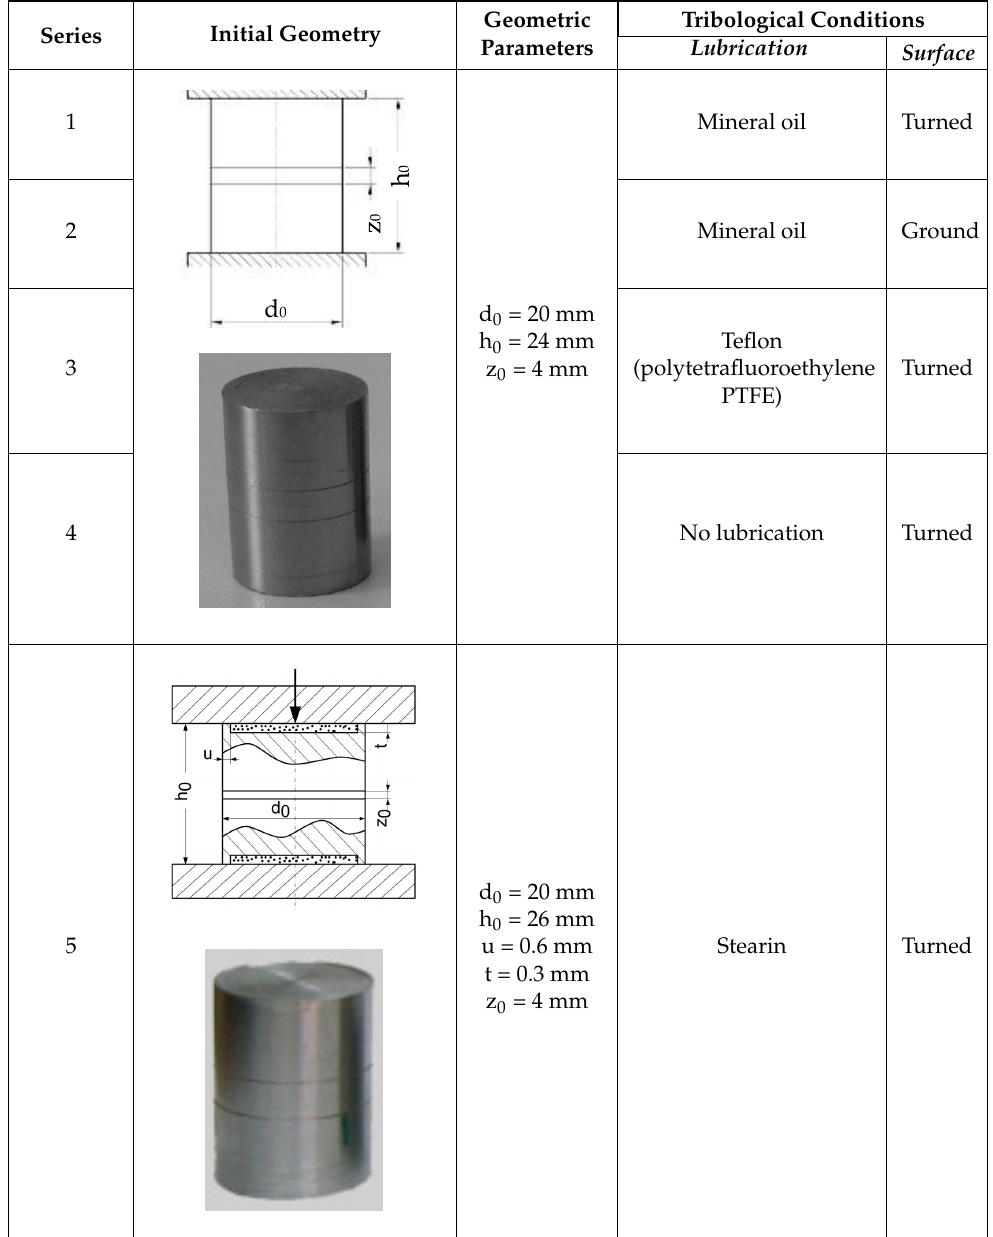
Table 2. Chemical composition of steel C45E.